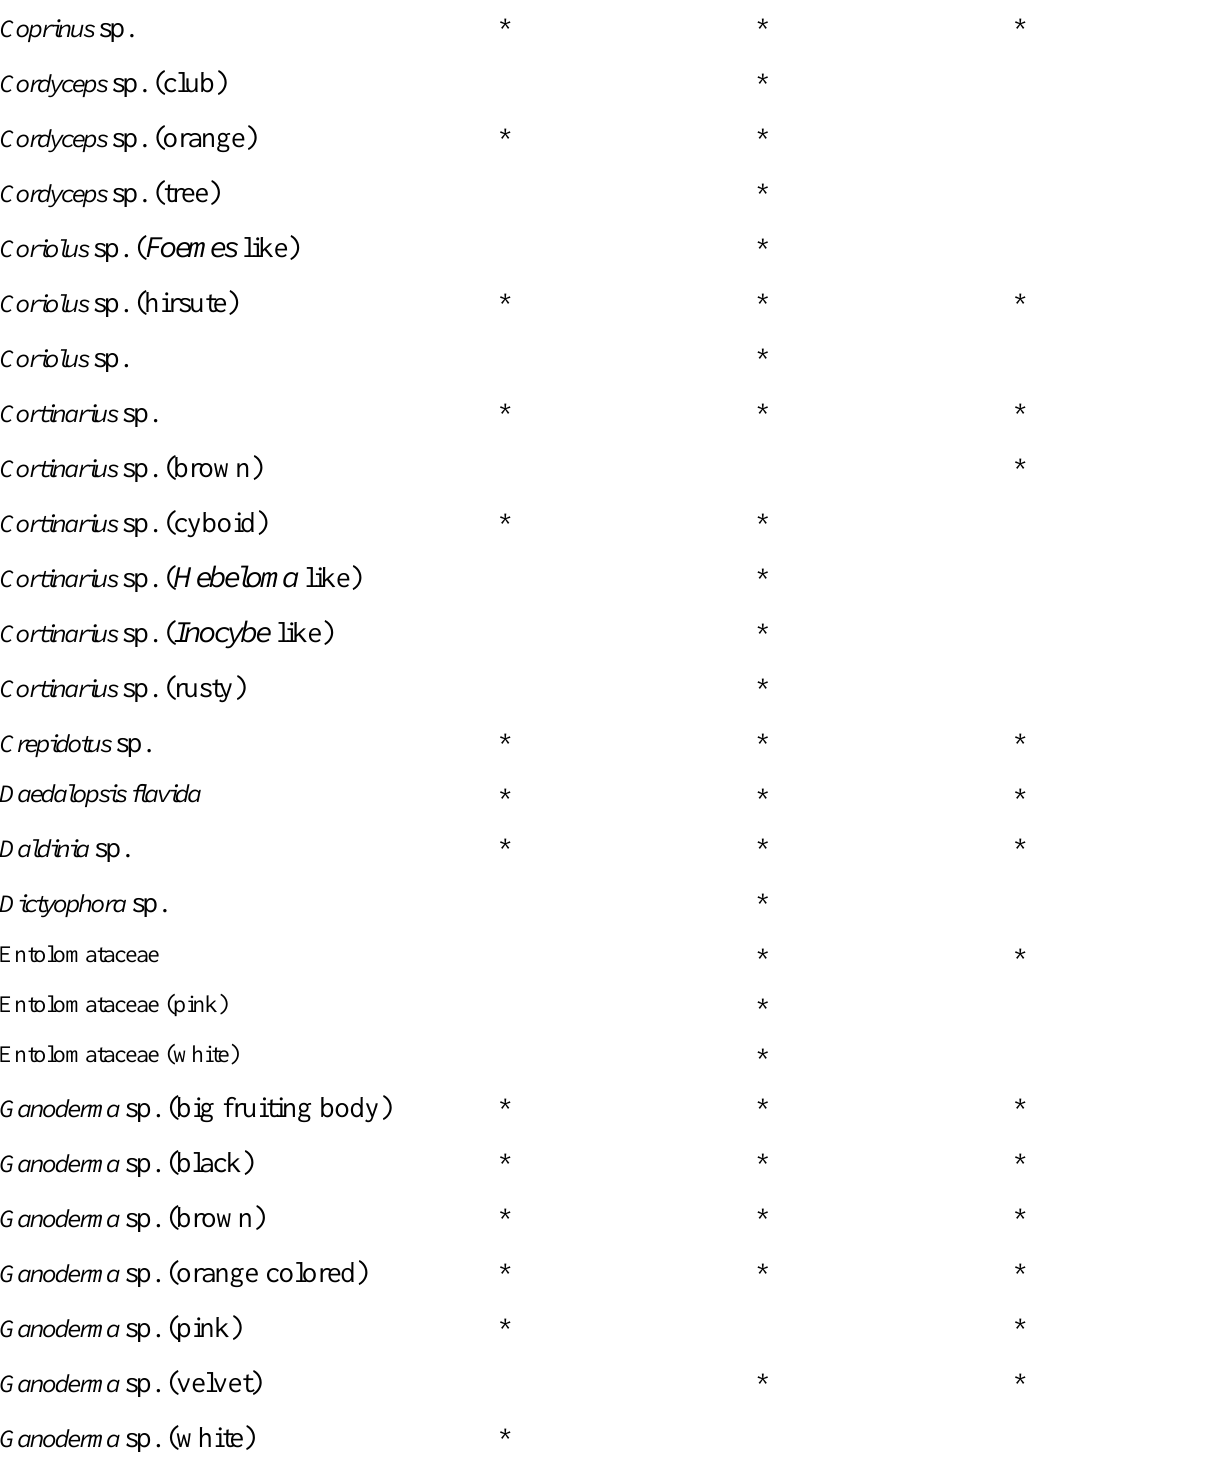
* * * Cordyceps sp. (club) * Cordyceps sp. (orange) * * Cordyceps sp. (tree) * Coriolus sp. ( Foemes like) * Coriolus sp. (hirsute) * * Coriolus sp. * Cortinarius sp. Cortinarius sp. (brown) Cortinarius sp. (cyboid) Cortinarius sp. ( Hebeloma like) Cortinarius sp. ( Inocybe like) Cortinarius sp. (rusty) Crepidotus sp. Daedalopsis flavida Daldinia sp. Dictyophora sp. Entolomataceae Entolomataceae (pink) * Entolomataceae (white) * Ganoderma sp. (big fruiting body) * * * Ganoderma sp. (black) * * * Ganoderma sp. (brown) * * * Ganoderma sp. (orange colored) * * * Ganoderma sp. (pink) * Ganoderma sp. (velvet) Ganoderma sp.